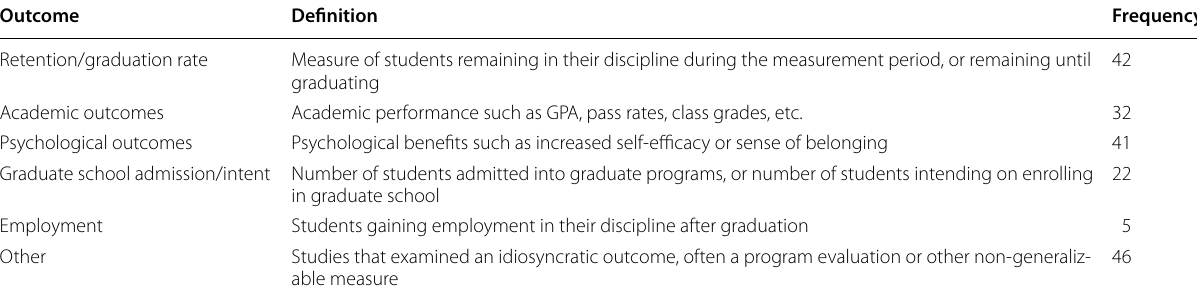
Table 4 Overview of articles that reported significance for each outcome Outcome Retention Number of articles that measured significance 20 Number of articles indicating positive